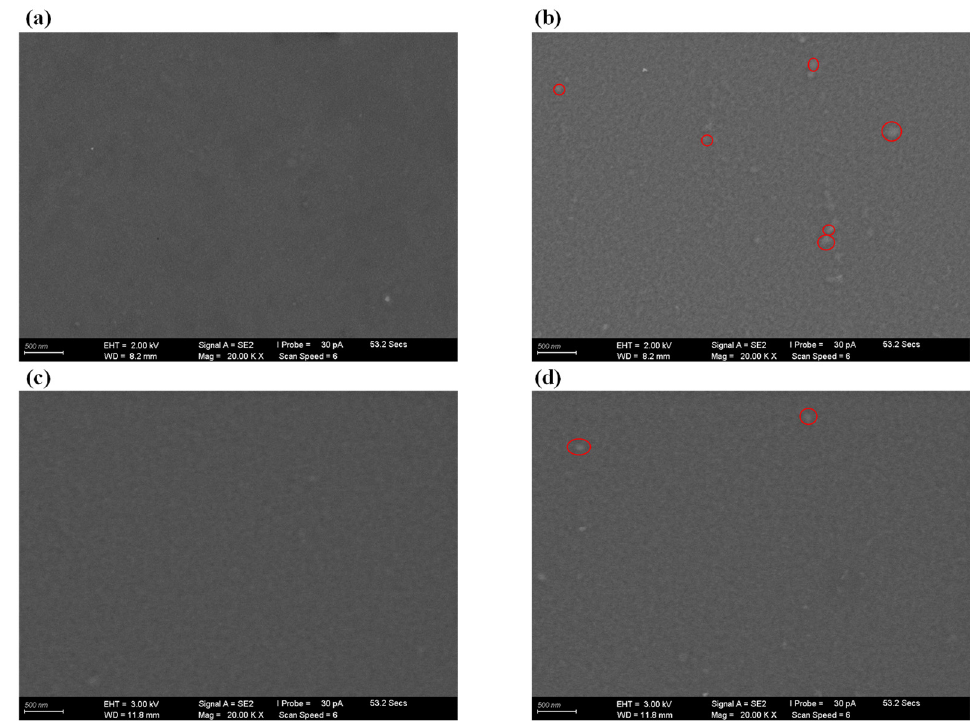
Figure 11. SEM images of PEDOT: PSS without and with different organic additives and subjected to FA treatment: ( a ) PEDOT: PSS, ( b ) PEDOT: PSS-sorbitol (4 wt%), ( c ) PEDOT: PSS-maltitol (4 wt%), ( d ) PEDOT: PSS-sorbitol-maltitol (3:1).